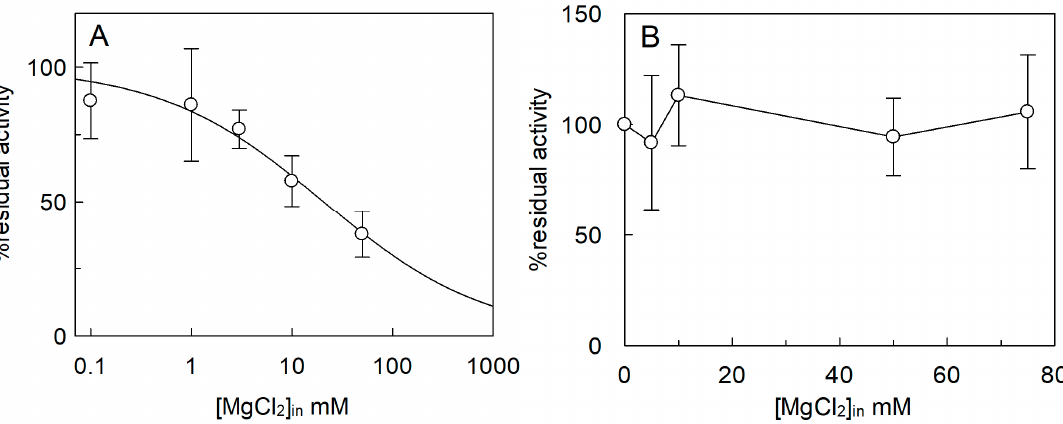
Figure 8. Effect of intraliposomal Mg 2+ on the transport activity of Sl CAT2. Sl CAT2 was purified and reconstituted in proteoliposomes as described in Section 4.4. ( A ) Dose–response curve for the inhibition of Mg 2+ in the presence of intraliposomal ATP. Transport was measured in 20 min, as described in Section 4.5, by adding 100 µM [ 3 H]Arg to proteoliposomes containing the indicated concentrations of Mg 2+ , 200 mM sucrose, and 15 mM ATP at pH 7.5. ( B ) Analysis of the inhibition of Mg 2+ in the absence of intraliposomal ATP. Transport was measured in 20 min, as described in Section 4.5, by adding 100 µM [ 3 H]Arg to proteoliposomes containing the indicated concentrations of Mg 2+ and 200 mM sucrose. Transport activity was calculated as the percent of residual activity with respect to condition without any addition (in absence of intraliposomal Mg 2+ ). Results are the means ± SD from three experiments.